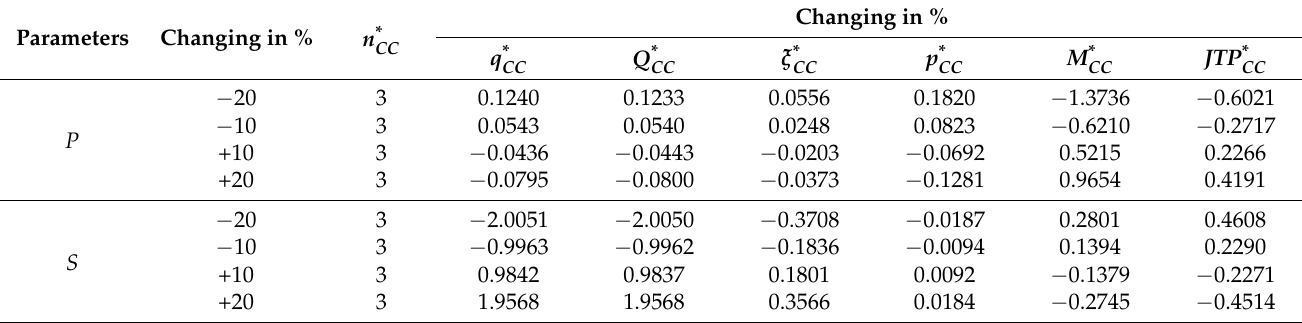
Table 2. Sensitivity analysis of major